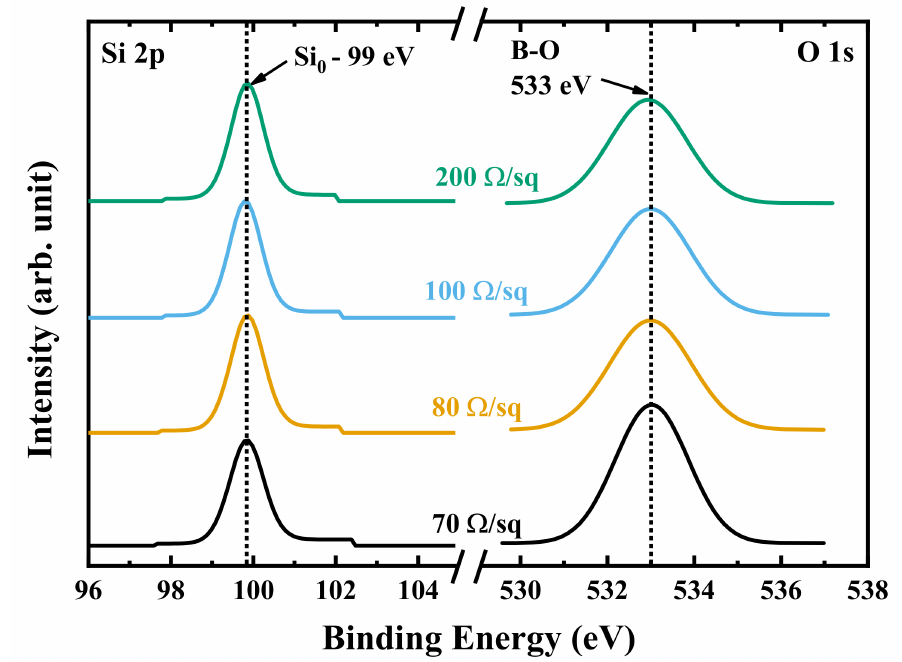
Figure 2. XPS analysis of silicon (binding energy (BE) (cid:27) 100 eV) and the boron–oxygen complex (BE = 533 eV) in the p + di ff used layer by R sheet variation with Si2p and O1s peak